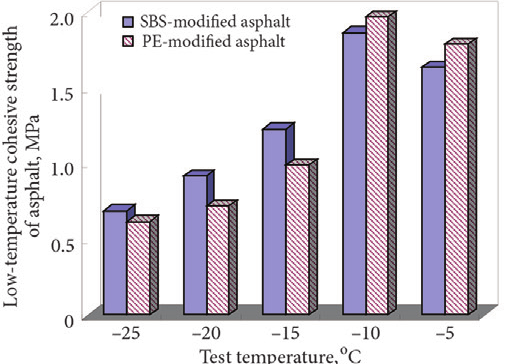
Figure 5. Change law of the two types of bitumen low-temperature cohesive strength after ageing for 6 h